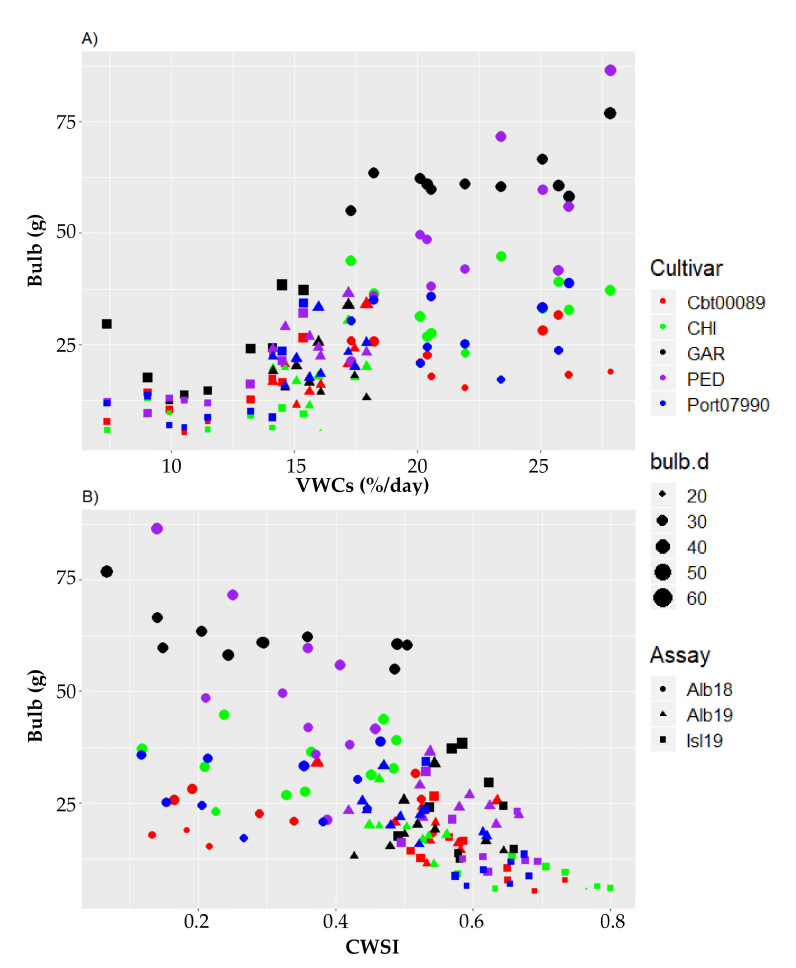
Figure 3. Scatterplot of the final bulb biomass for each cultivar across a gradient of ( A ) soil volumetric water content and ( B ) mean crop water stress index. Red points correspond to the cultivar Cbt00089, green points to Chinch ó n, black points to Gardacho, purple points to Pedroñeras, and blue points to Port07990. The di ff erent sizes of the points are related to the bulb diameter (bulb.d) and the di ff erent shapes are related to each corresponding experimental assay as shown in the